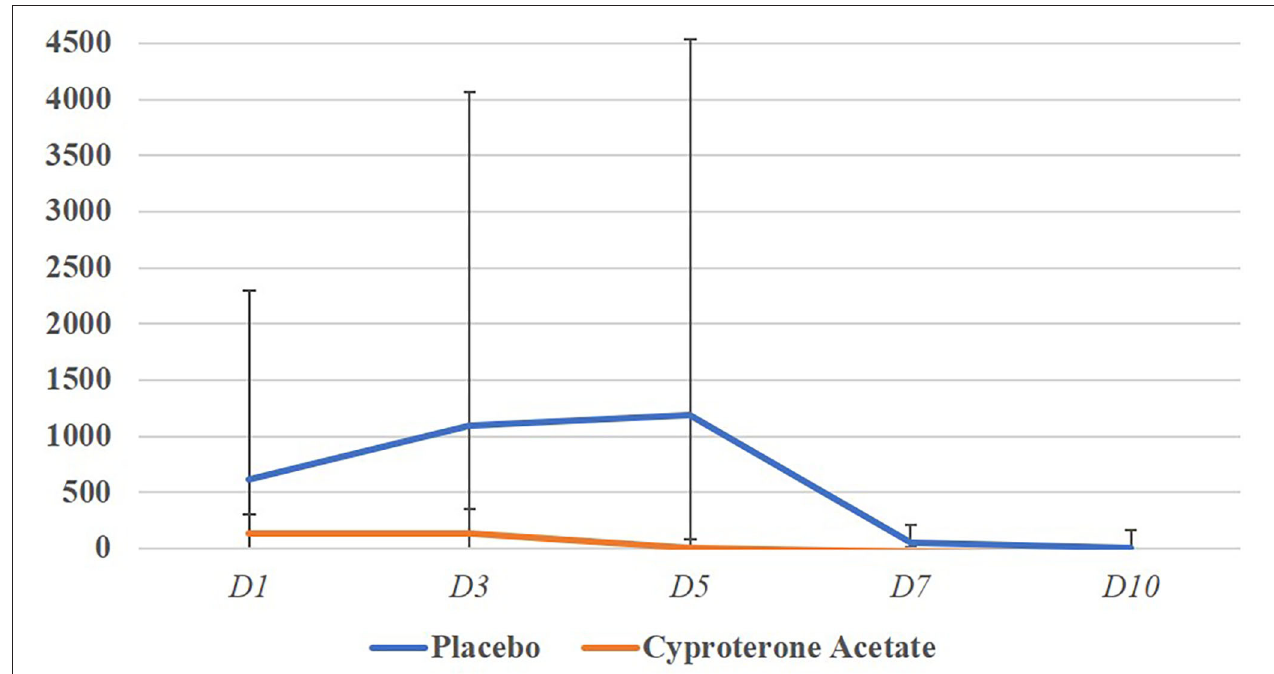
FIGURE 1 | Mean percentage increase in testosterone levels per days and treatment groups.